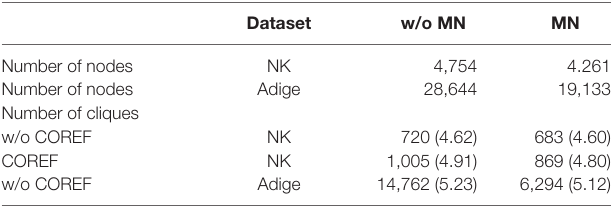
TaBle 1 | Number of nodes and cliques in the networks with and without mention normalization (MN) and coreference resolution (COREF—only for English).